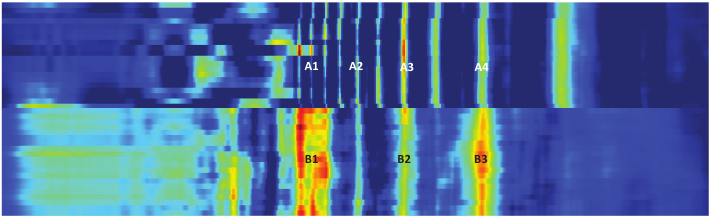
Figure 4. The enhanced version of the combined LOFAR and DEMON spectrum in Figure 3 with comb filtering, where the frequency (horizontal) axis is shown logarithmically for better